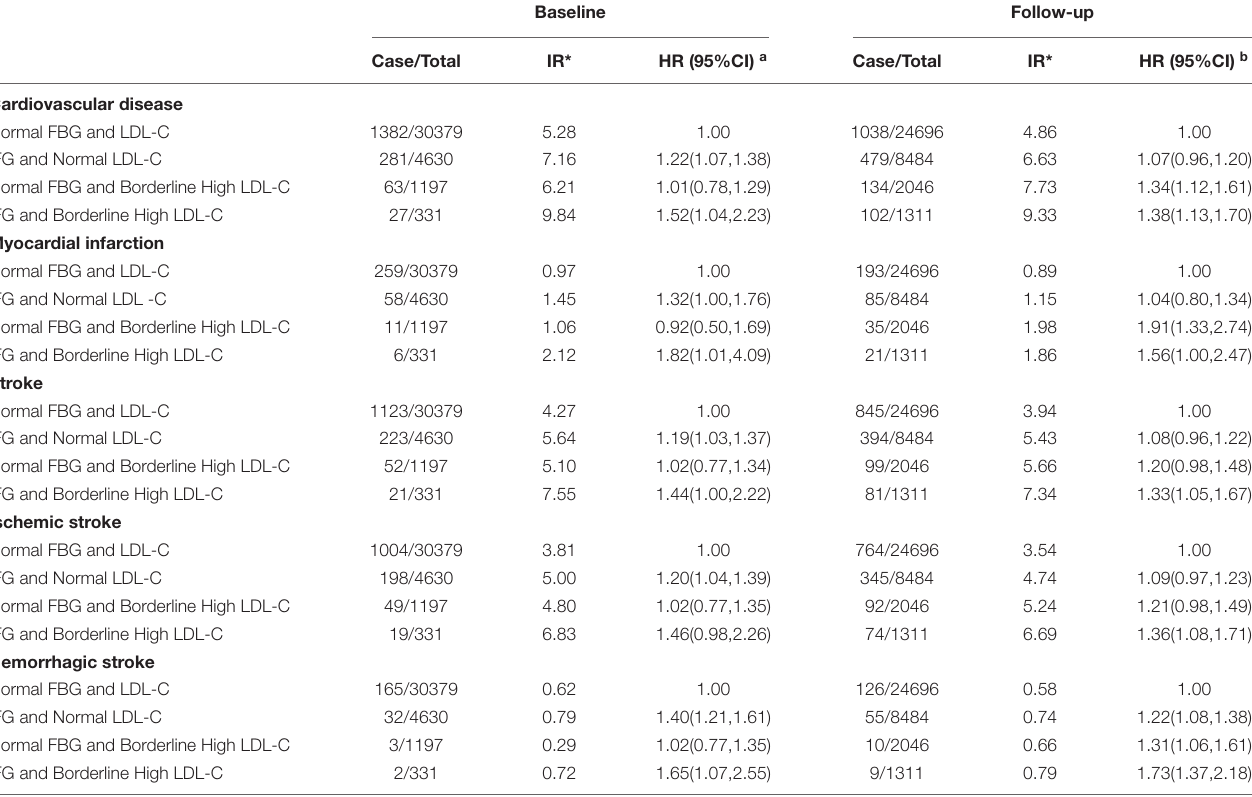
TABLE 2 | Influence of combined effects of IFG and borderline high LDL-C on CVD. Baseline